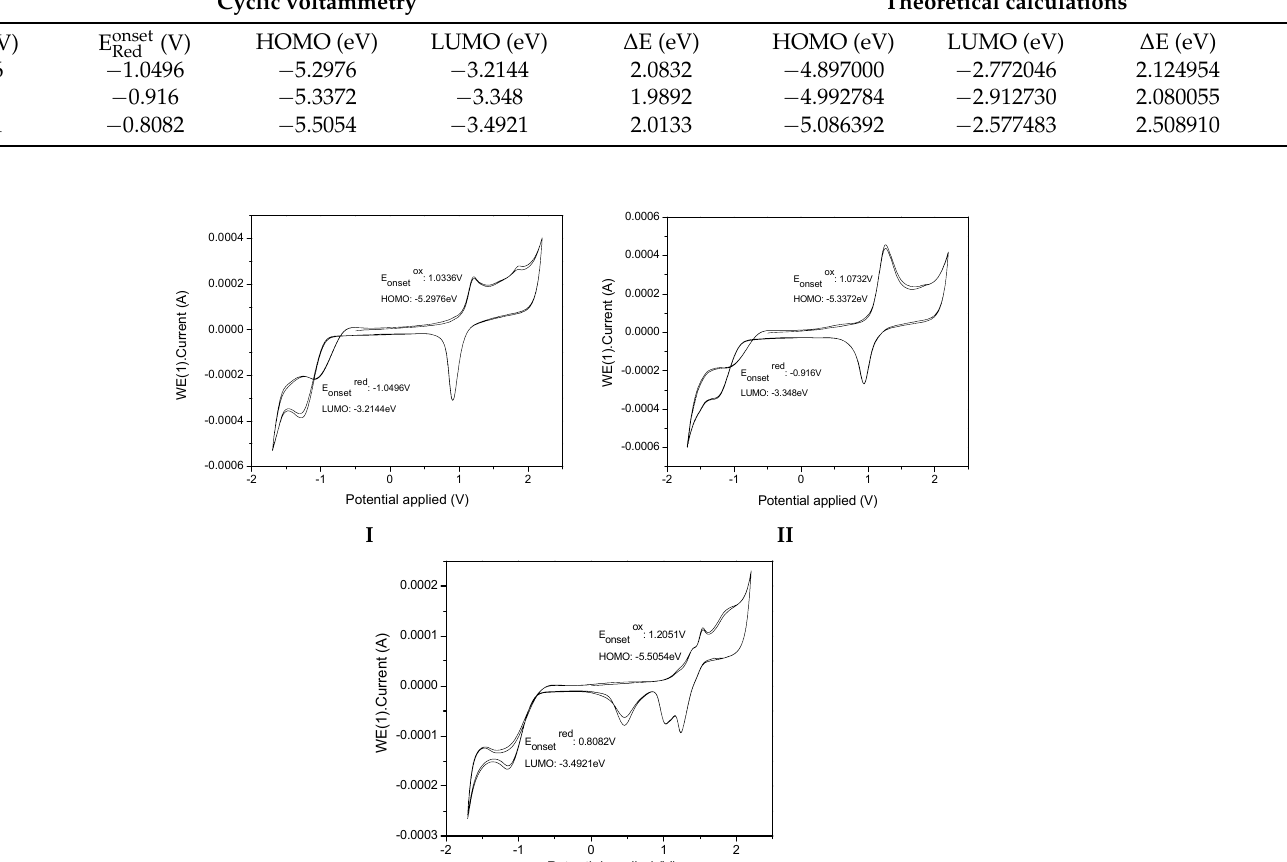
Table 4. Electronic properties I , II and III .